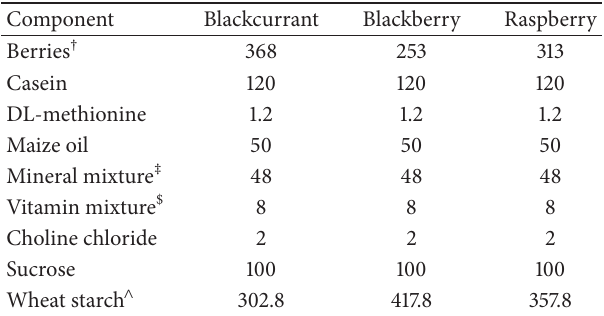
Table 1: Composition of test diets 1 (g/kg,